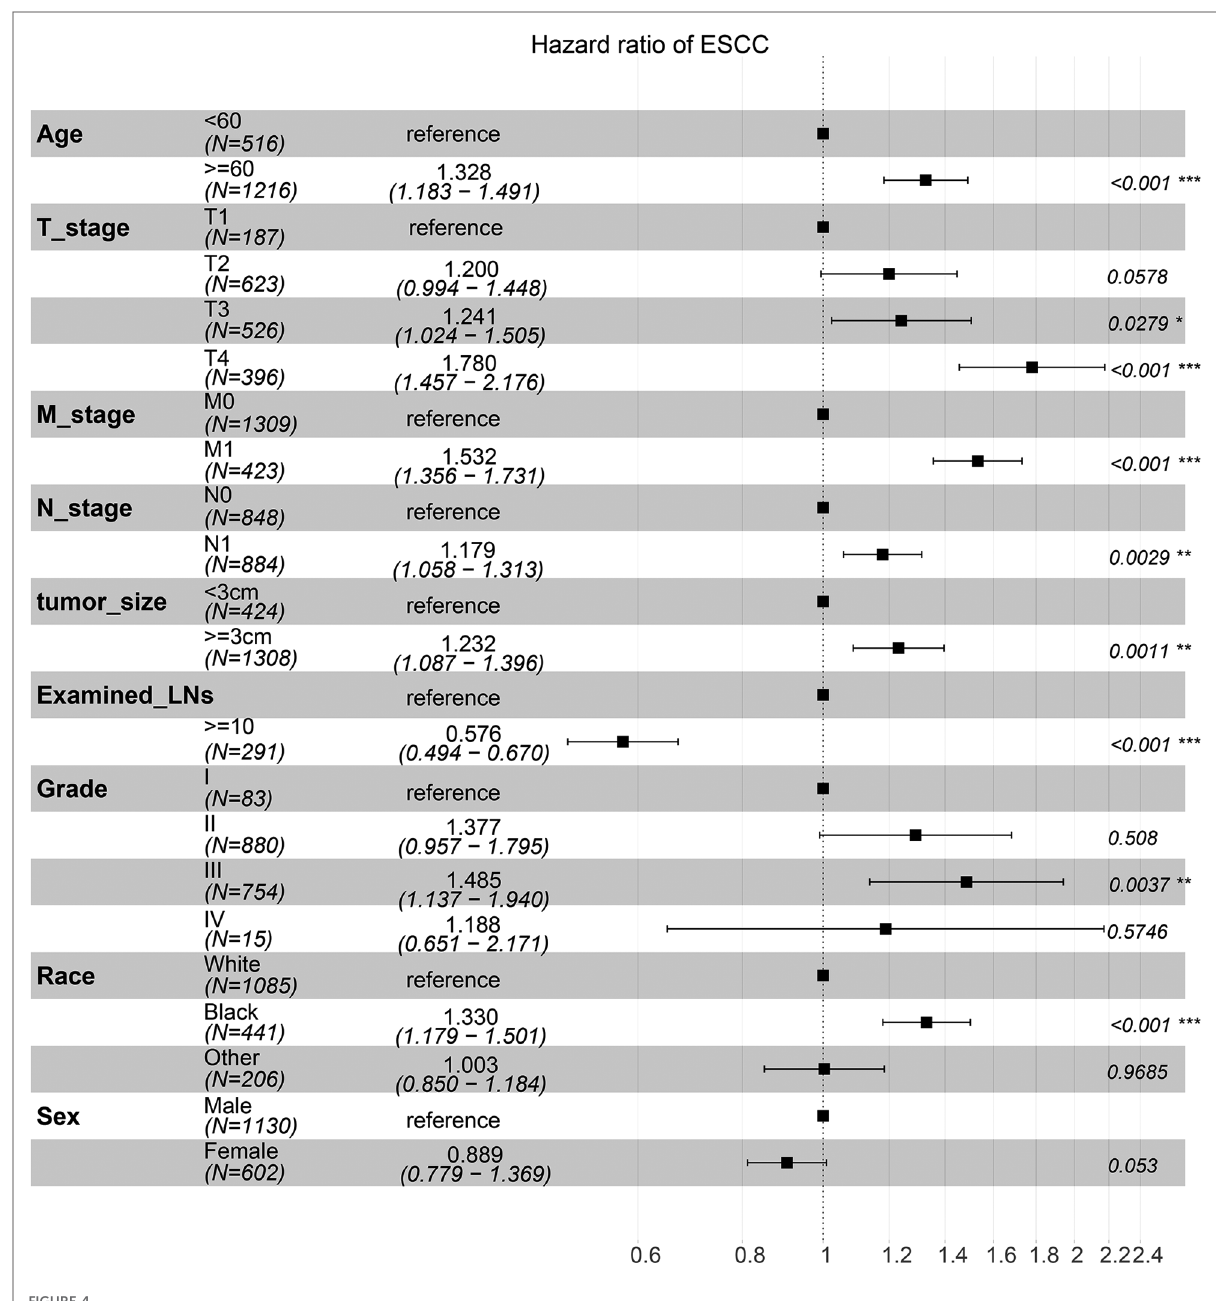
FIGURE 4 Multivariate Cox regression